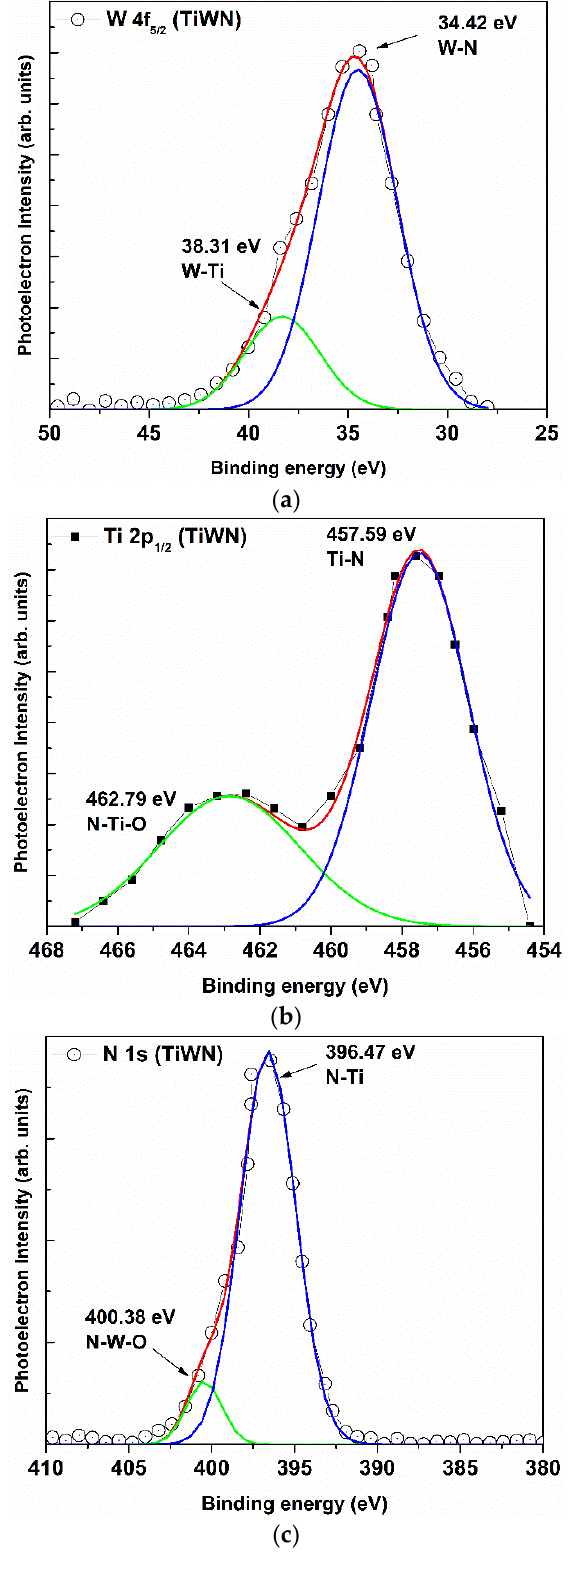
Figure 3. High resolution XPS spectra of the Ti-W-N coating deposited by RF magnetron sputtering.